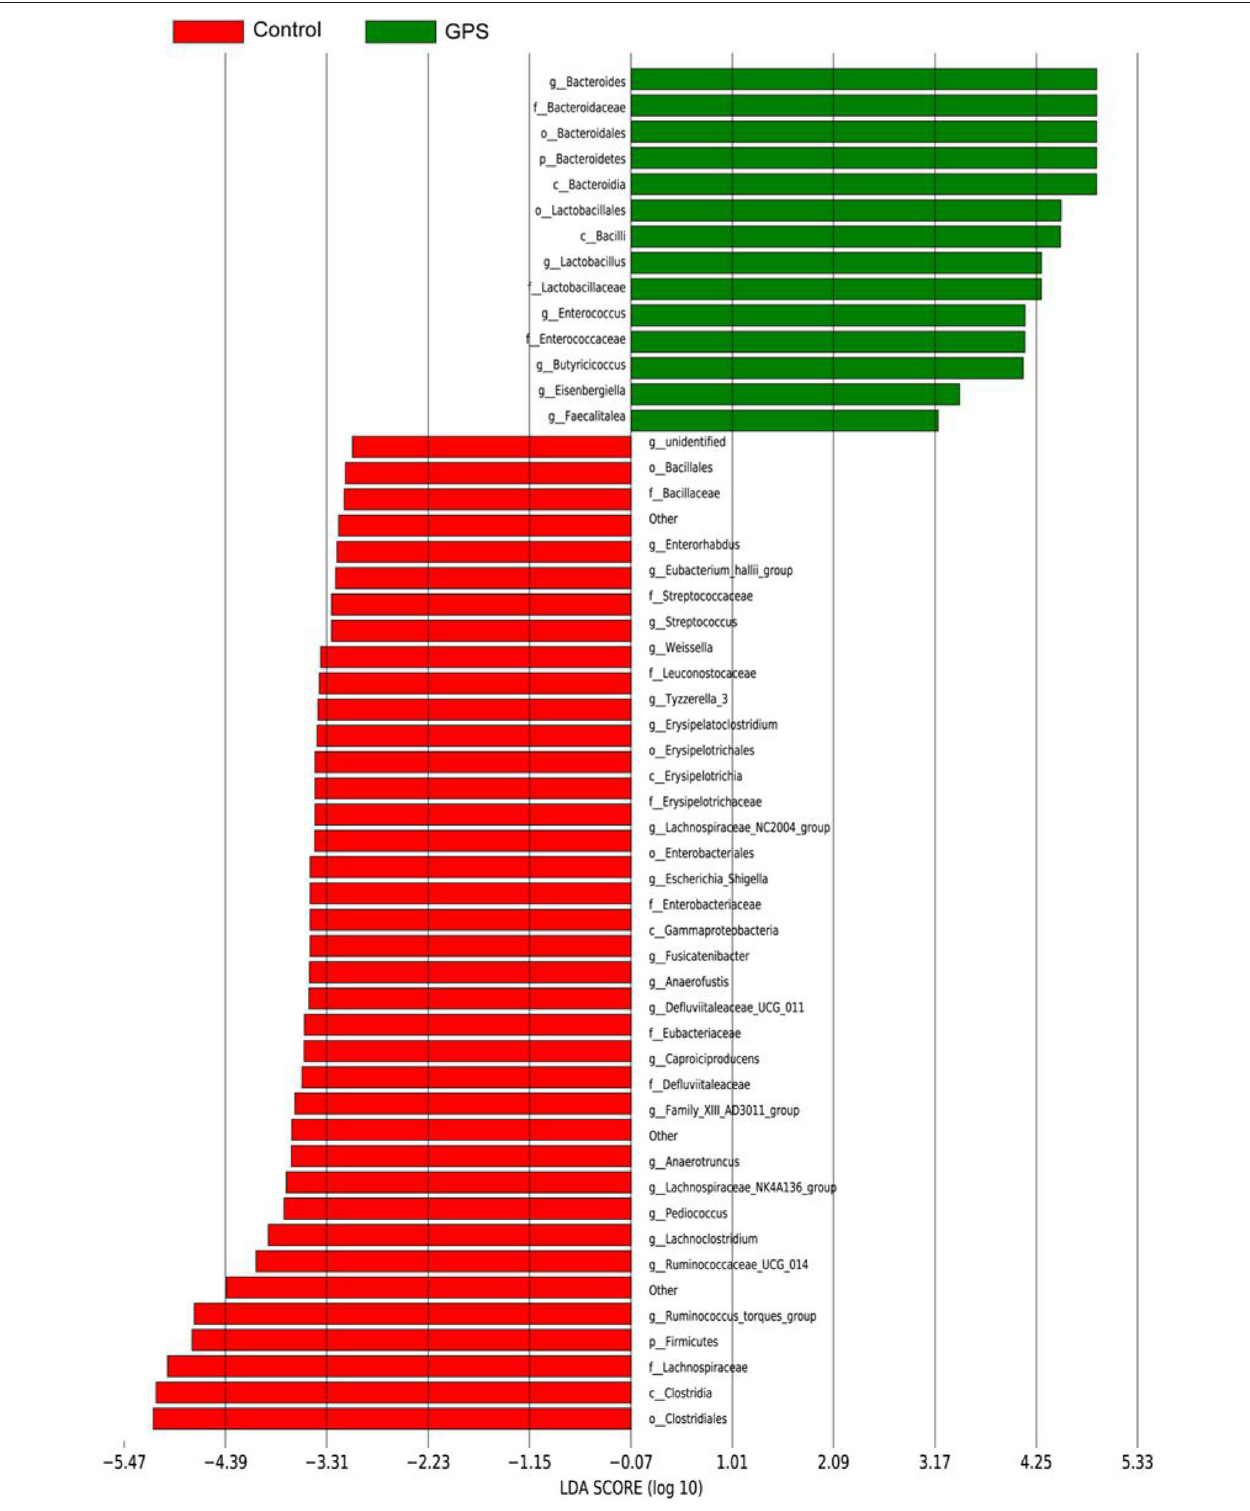
FIGURE 8 | The LDA Effect Size was used to analyze the comparison between the GPS-H group and the control group, and an intra-subgroup comparison analysis between the two groups was also performed to find substances with significant differences in abundance between the groups.